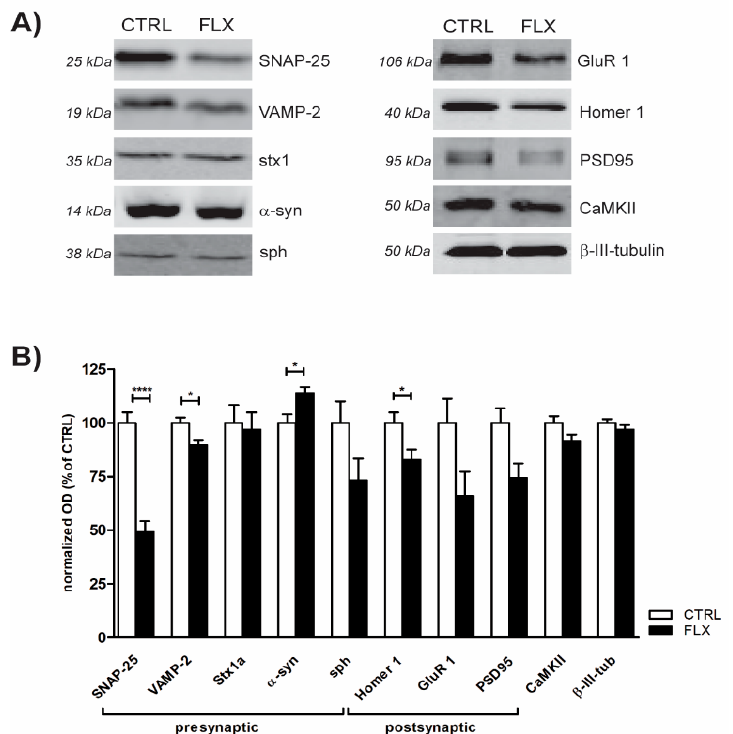
Figure 3. FLX treatment changes the abundance of synaptic proteins. ( A ) Representative immunoblots of selected pre- and postsynaptic proteins isolated from three-week-old cortical neurons treated for 90 min with control solution or 100 µM FLX. ( B ) Quantification of ( A ). The intensity of the signal for each protein was normalized to b-III-tubulin and expressed as a percentage of control. Data originate from ≥ 3 independent experiments. Statistical significance was evaluated using Student’s t -test.